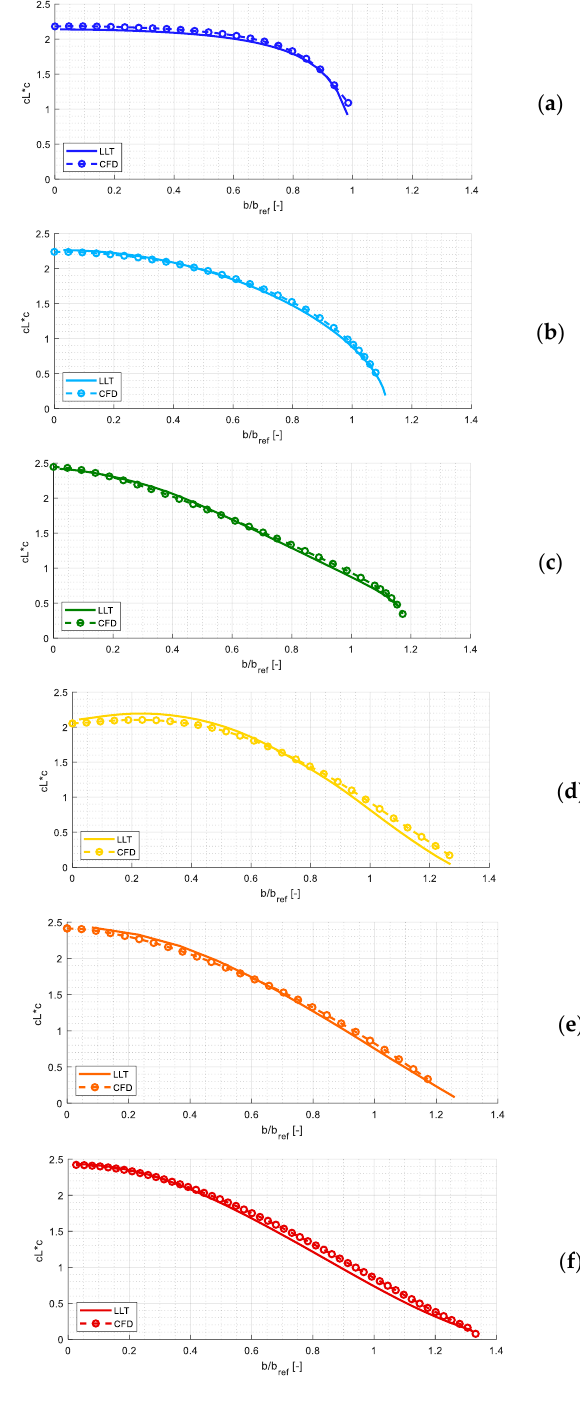
Figure 6. The x-component of skin friction coefficient on the computed wings. From the calculated polars, a solution was also selected where the detached flow begins to show, approximately two degrees of the angle of attack before maximum lift coefficient is reached. ( left side ); lift distribution over the wingspan at desired lift force, solid line — lifting line theory, dashed line — CFD ( right side ) . From top to bottom: ( a ) rectangular, ( b ) elliptic, ( c ) trapezoidal, ( d ) BSLD-TW, ( e ) BSLD-UTW and ( f ) FREE-OPT wing.